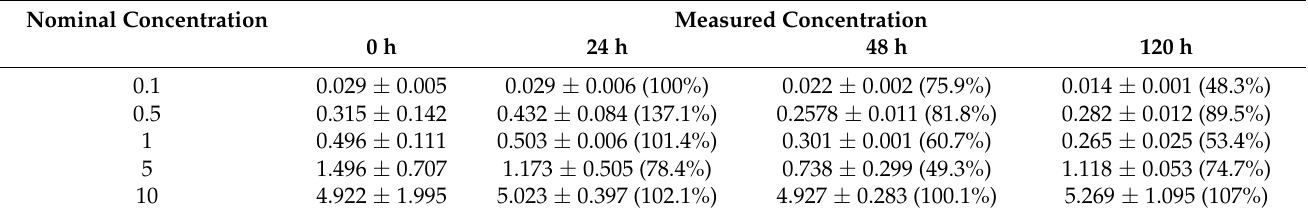
Table 2. B(a)P concentration (mg/L) over time for the five exposure concentrations. Percentage of recovered B(a)P compared to that measured at time 0 is indicated in brackets. Values are given as mean ± S.D. ( n =